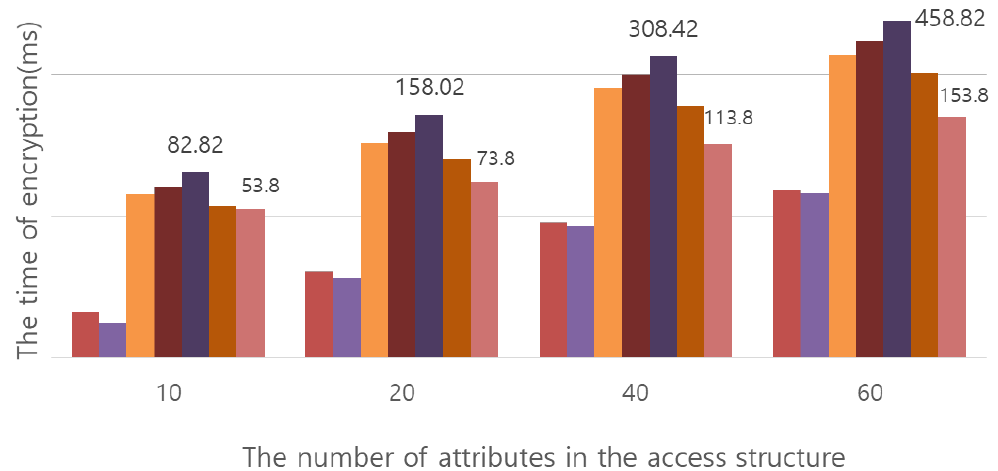
Figure 11. Comparison of data encryption time between existing CP-ABE schemes and the proposed scheme.